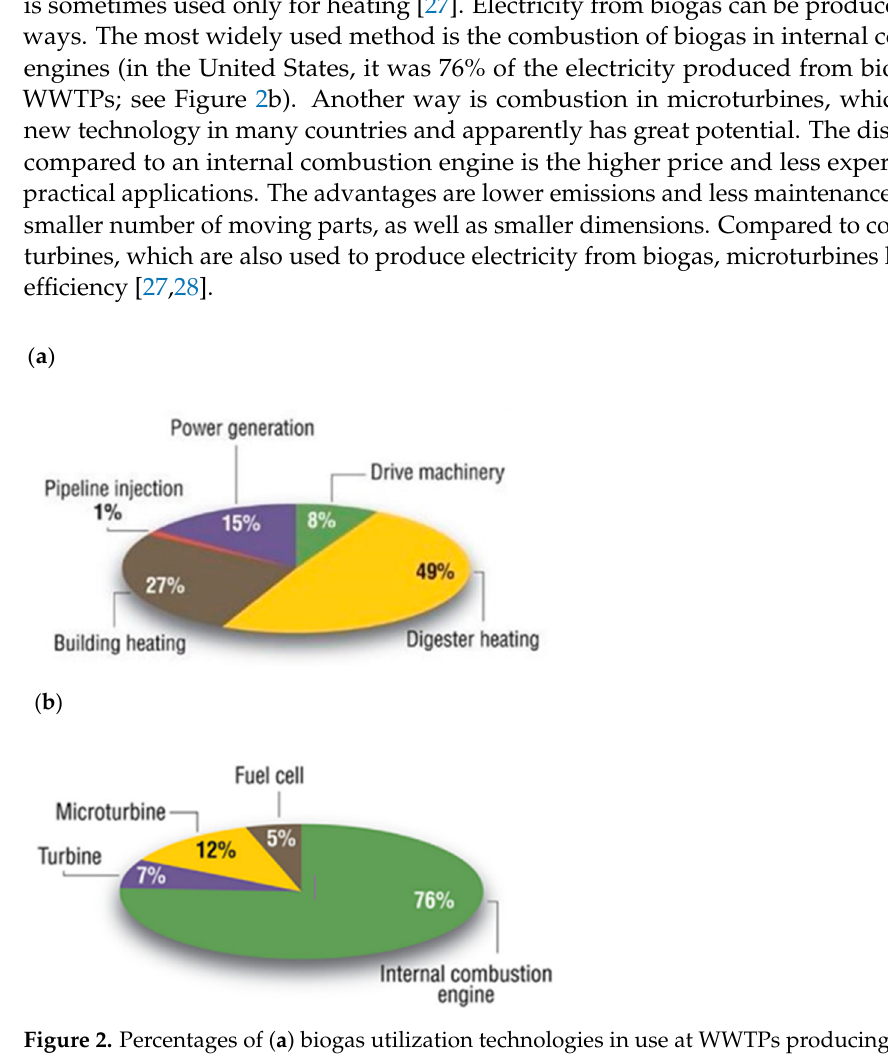
Figure 2. Percentages of ( a ) biogas utilization technologies in use at WWTPs producing biogas [27]; ( b ) electricity generation technologies in use at WWTPs that produce biogas. ( b ) electricity generation technologies in use at WWTPs that produce